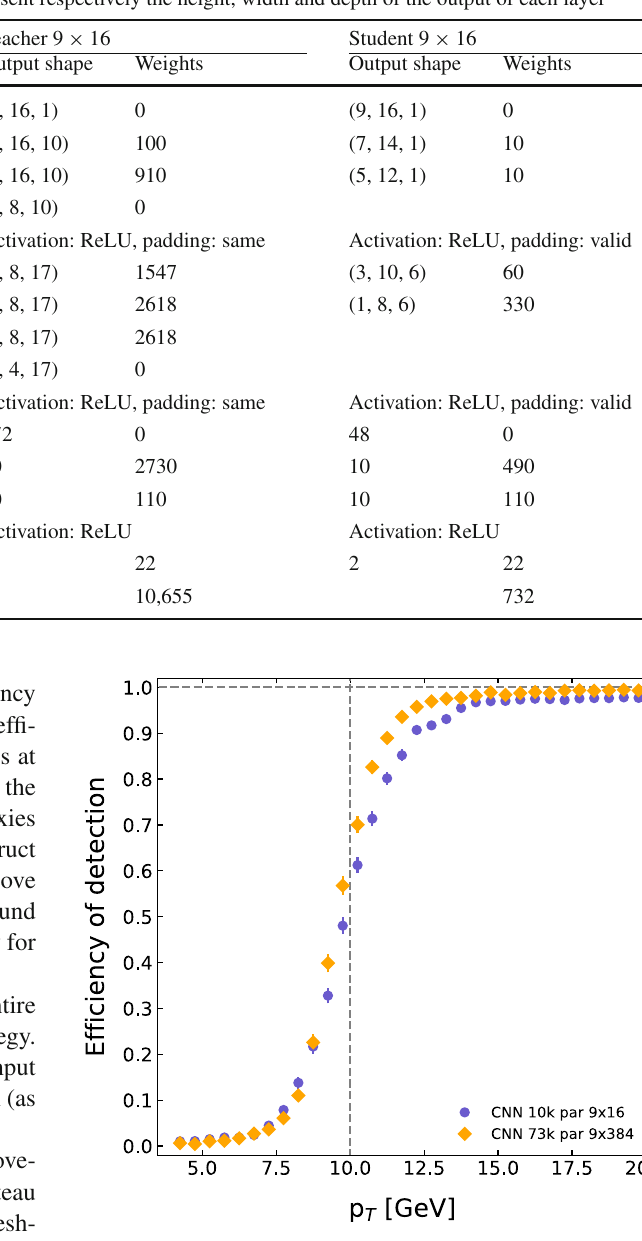
Fig. 6 Trigger efficiency comparison. The curves have been realized withanominalthresholdat10GeV.Theidealcasewouldshowsasastep functionwithefficiencyequalto0beforethresholdandto1afterthresh- old. Statistical uncertainties computed as binomial confidence intervals are shown as well. If not visible, they’re smaller than the markers size. In orange (diamonds) the model taking as input 9 × 384 pixels images. In indigo (circles) the same model architecture taking as input 9 × 16 pixels images (the model adopted afterward as “Teacher”)